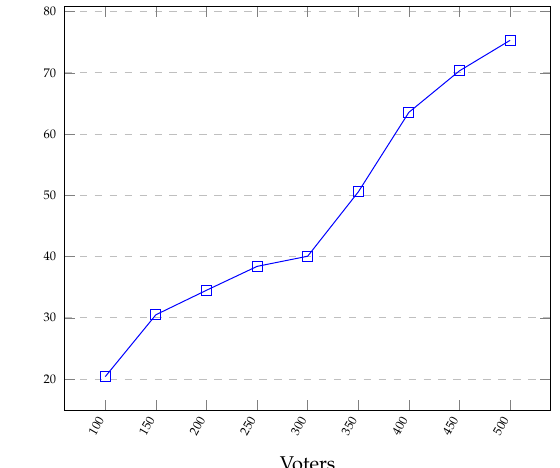
Figure 8. The voter authorisation time is plotted as a function of the number of voters. The authorisa- tion time is an approximately linear function of the voter population size, when it is the range 100 to 500 voters, which underlines the scalability of PVPBC.